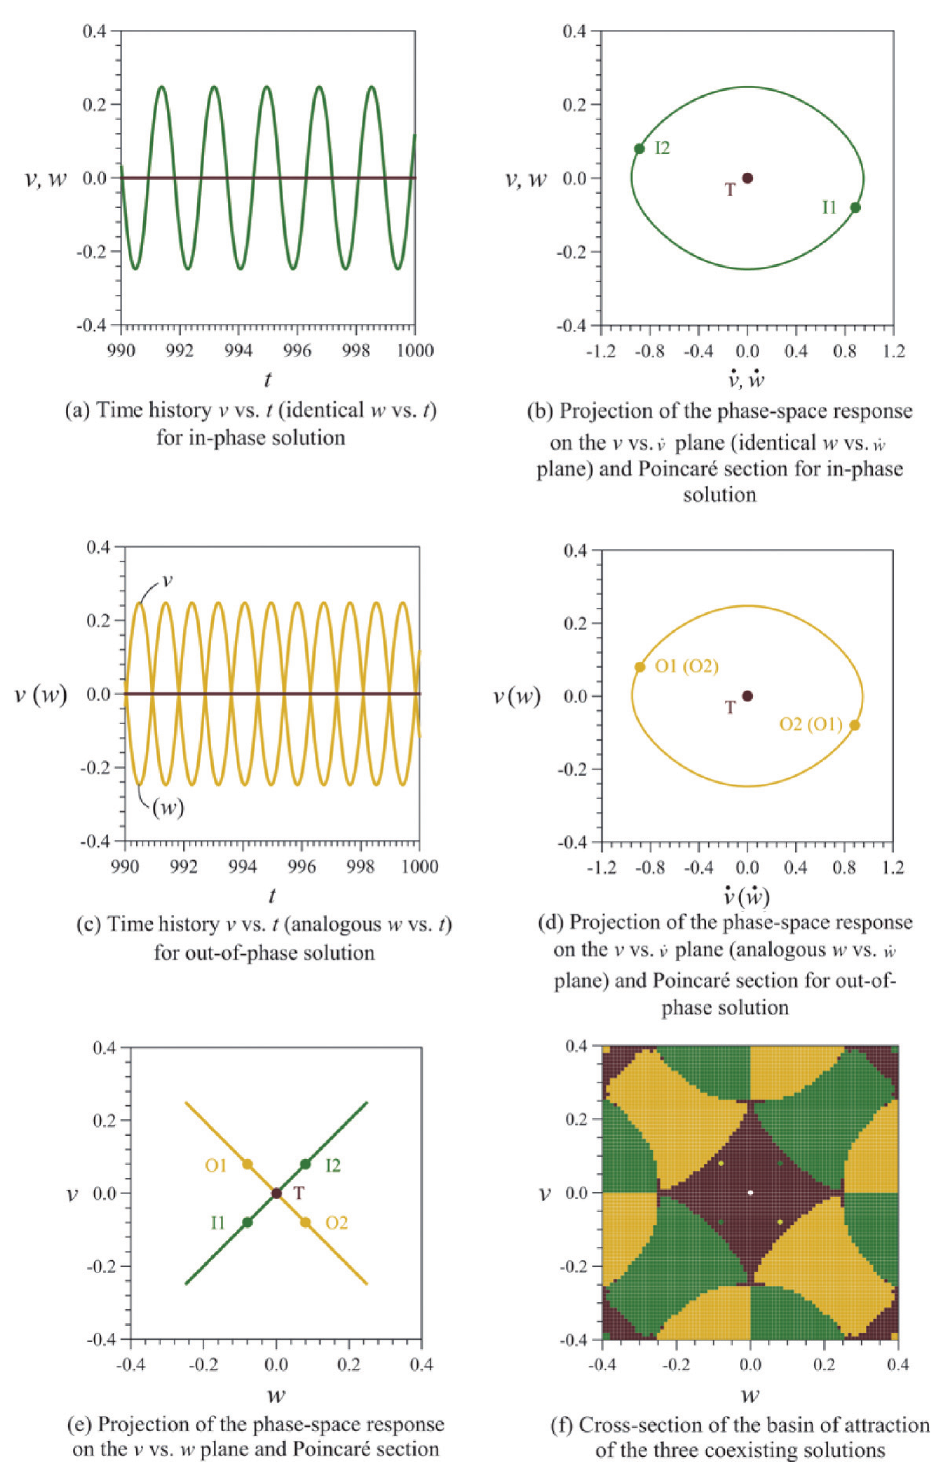
Fig. 6. Stable coexisting solutions at q u = 0.38 and Ω u = 2 ω 0